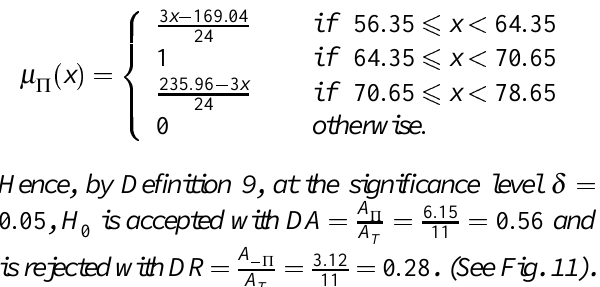
0 55 ( DR (cid:2) (cid:0)